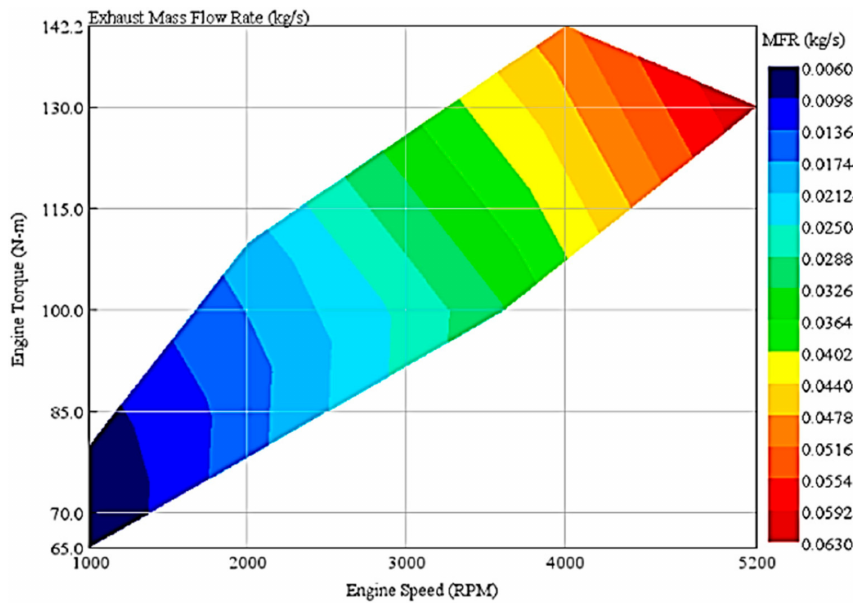
Figure 18. Engine Exhaust Mass Flow Rate.